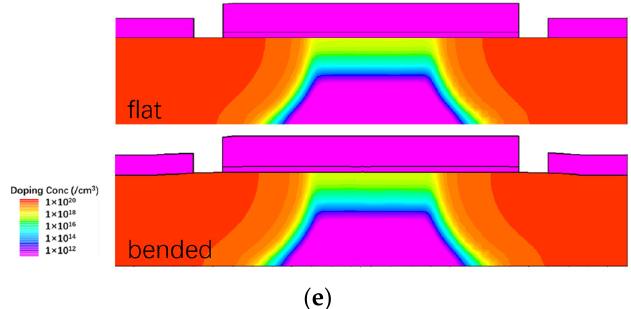
Figure 1. ( a ) Optical image of the gigahertz flexible silicon nanomembrane (SiNM) thin-film transis- tors (TFTs) on a bended plastic substrate. ( b ) Cross-sectional schematic of the flexible double-gate TFTs (drawn not to scale). ( c ) Measurement setup for the bending tests of the SiNM TFT. ( d ) Schematic of bending strain calculations for flexible SiNM TFT (drawn not to scale). ( e ) Schematic cross-section structure and doping concentration of the modelled flat and bended TFT (drawn not to scale).